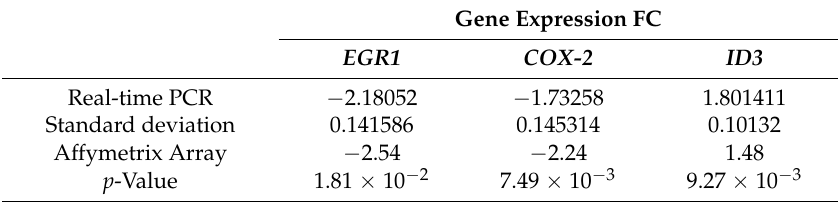
Table 2. Real-time PCR confirmation of the gene expression measured by Affymetrix arrays. Differential expression of EGR1 , COX-2 and ID3 following the eight-week supplementation with OLE relative to PBO. Two housekeeping genes were combined ( GAPDH and β -actin) for reference. FC is relative to